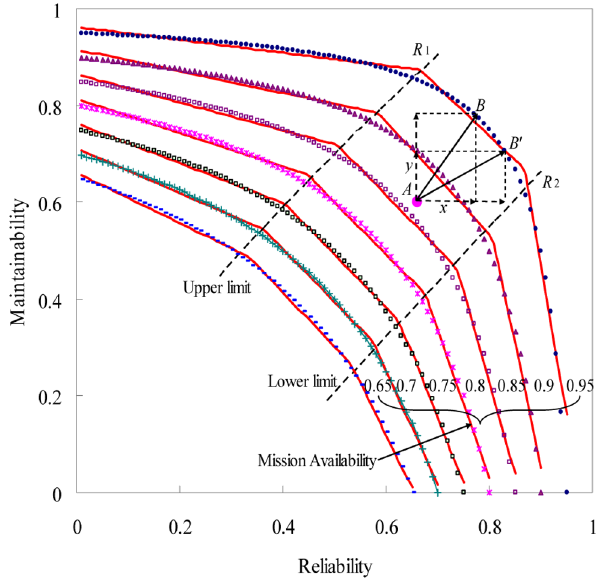
Figure 7. Determination of the no saturation interval. The solid line is the fitted piecewise-linear models. The dashed curve is the change trend between reliability and maintainability with mission availability 0.65(0.05)0.95. The dotted line is the fitted linear models.